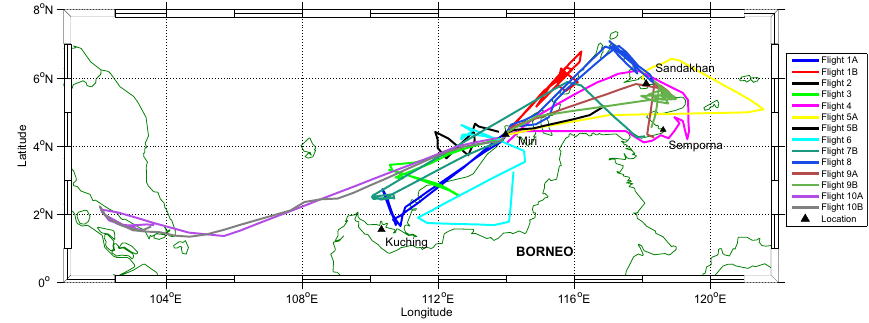
Fig. 10. Flight tracks of the DLR Falcon aircraft during November and December 2011 as part of the 2011 SHIVA